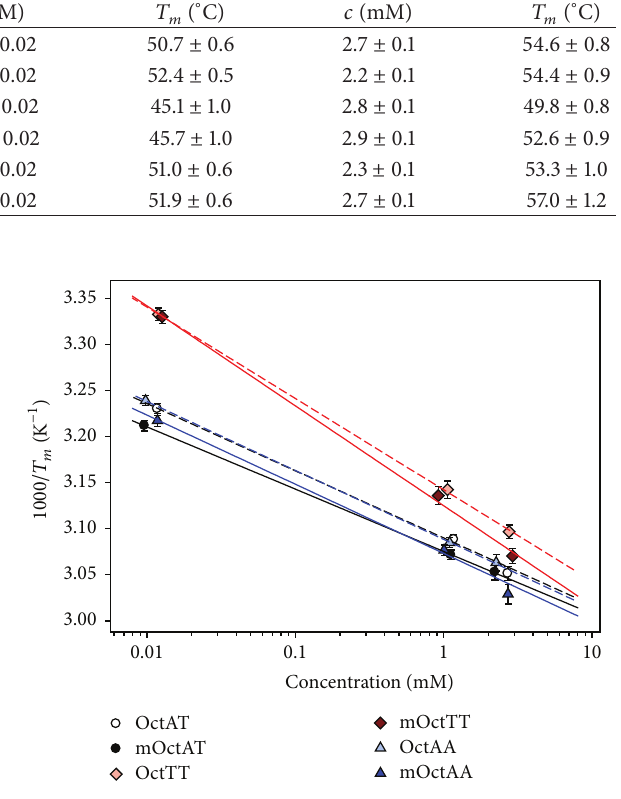
Figure4:Van’tHoffplotofthemeltingtemperaturesdeterminedfor various octamers concentrations (see Table 1). The lines represent the best least square fits according to